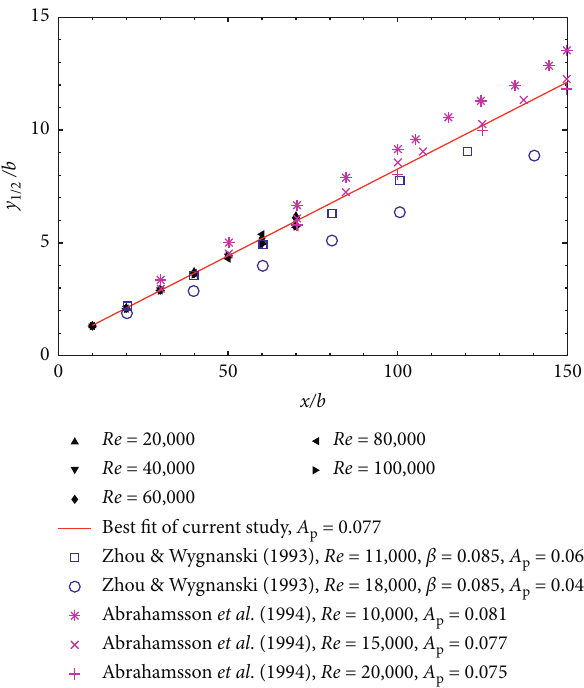
Figure 9: Plane wall jet growth rate for various Reynolds numbers.